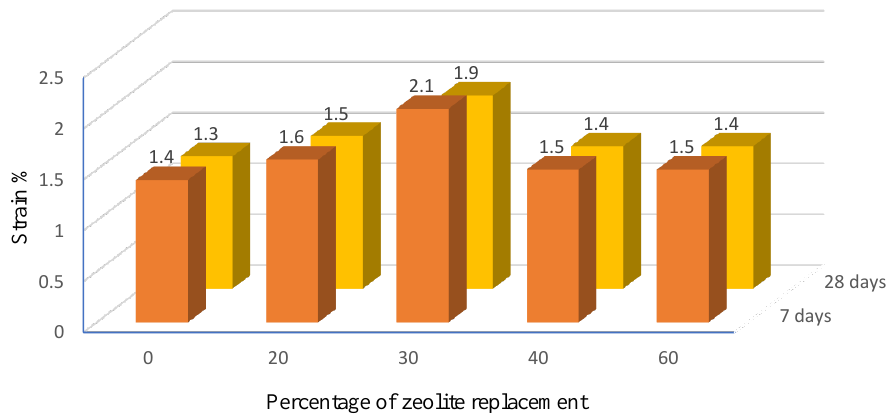
Figure 6. UCS values as a function of the zeolite replacement percentage.